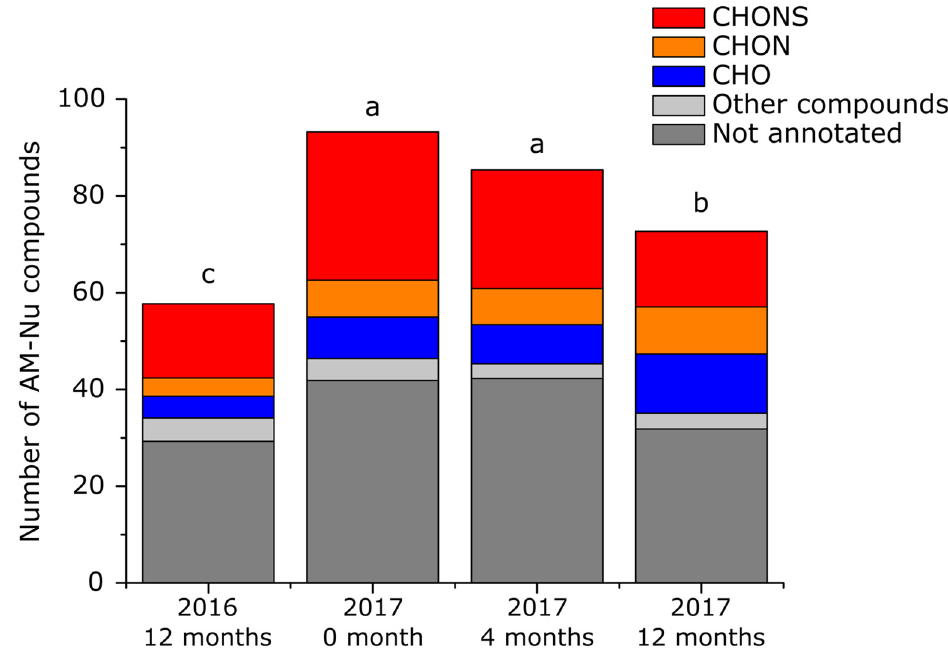
Figure 5. Number of nucleophilic compounds isolated during barrel aging. Annotation has been realized using online tools Oligonet [14], and Metlin. Different letters indicate significative differences determined by ANOVA and Tukey HSD test ( p -Value < 0.05). Other compounds regroup CH, CHN, CHNS, CHOS and CHOP compounds.